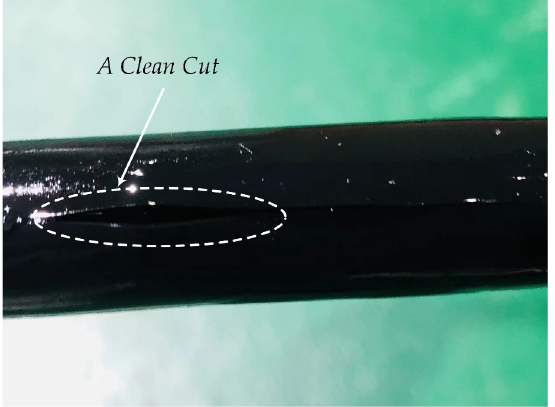
Figure 20. A destructed primary resilient bladder in the ultimate pressure